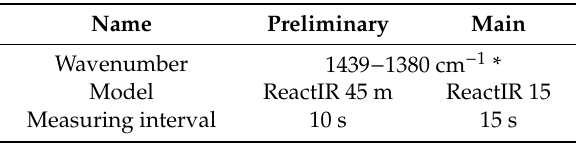
Figure 1. The estimation of the regression coefficients of Equation (2) in a main experiment. Table 3. Measurement conditions of Fourier transform infrared-attenuated total reflection spectroscopy (FT-IR-ATR) in the preliminary and the main experiments.